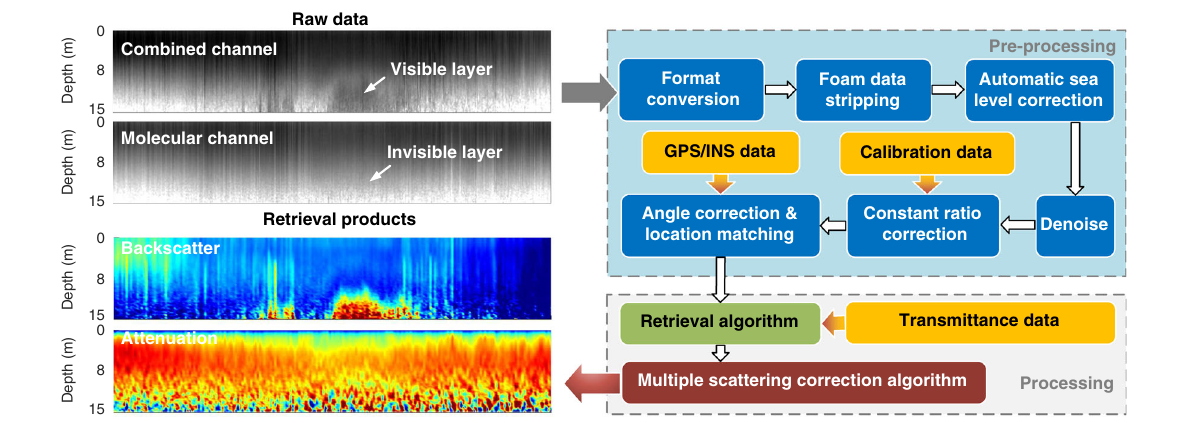
Fig. 2 Flow chart of HSRL data processing. Steps from raw data to retrieval